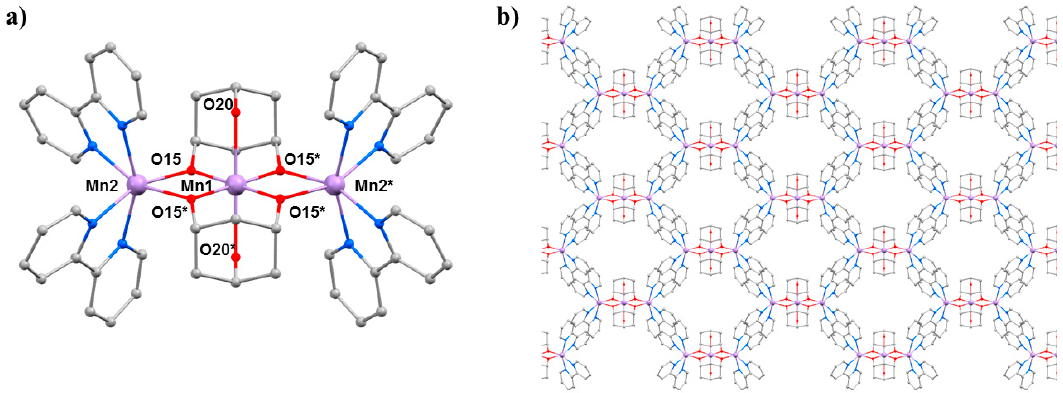
Figure 5. ( a ) The molecular structure of complex 3 . ( b ) Packing of the cations of complex 3 viewed down the a -axis. Colour code: Mn = lilac, O = red, N = blue, C = grey. H atoms, solvent molecules and counterions are omitted for clarity.